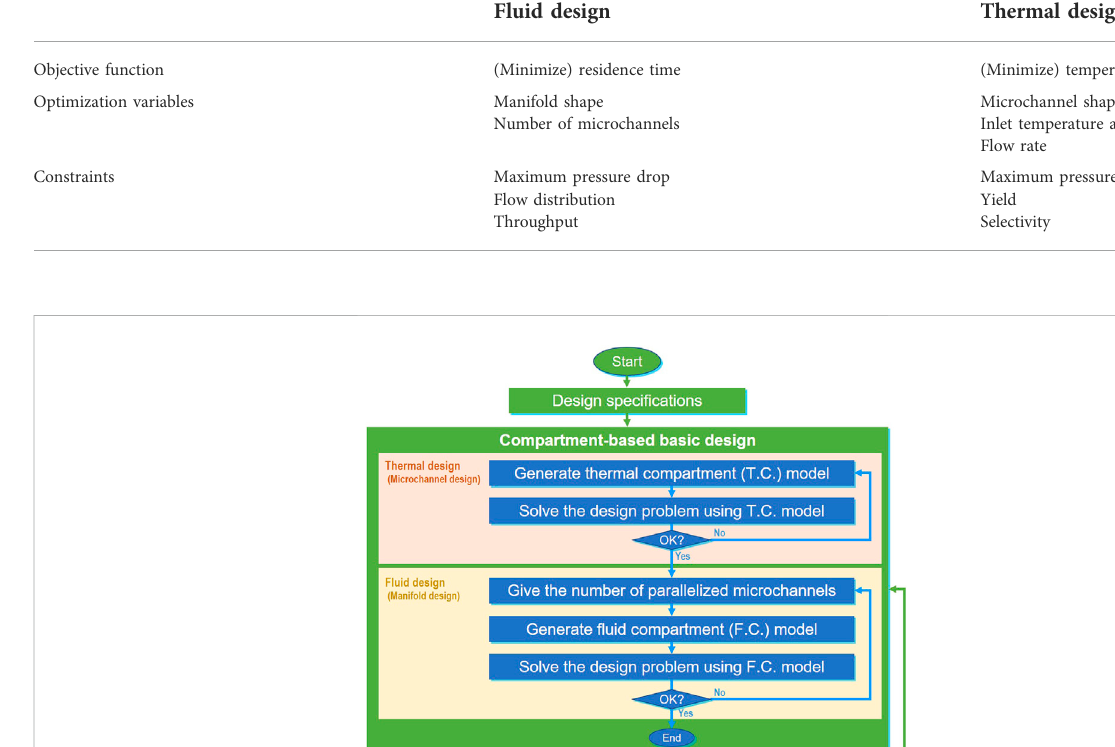
TABLE 1 A design problem of microreactors.